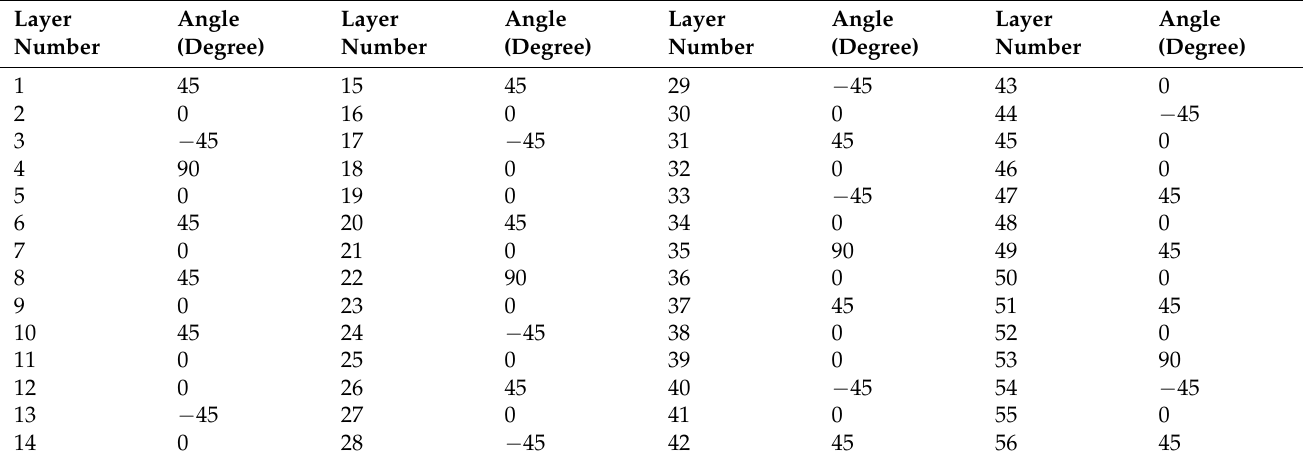
Table 2. The layer structure of the composite laminated